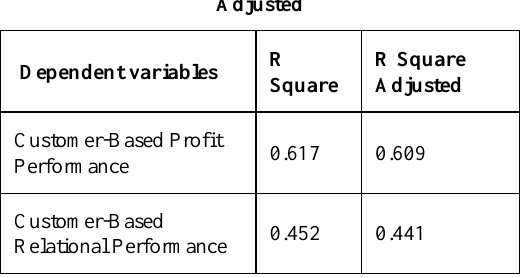
Table 6: Path Significance of the Structural Model